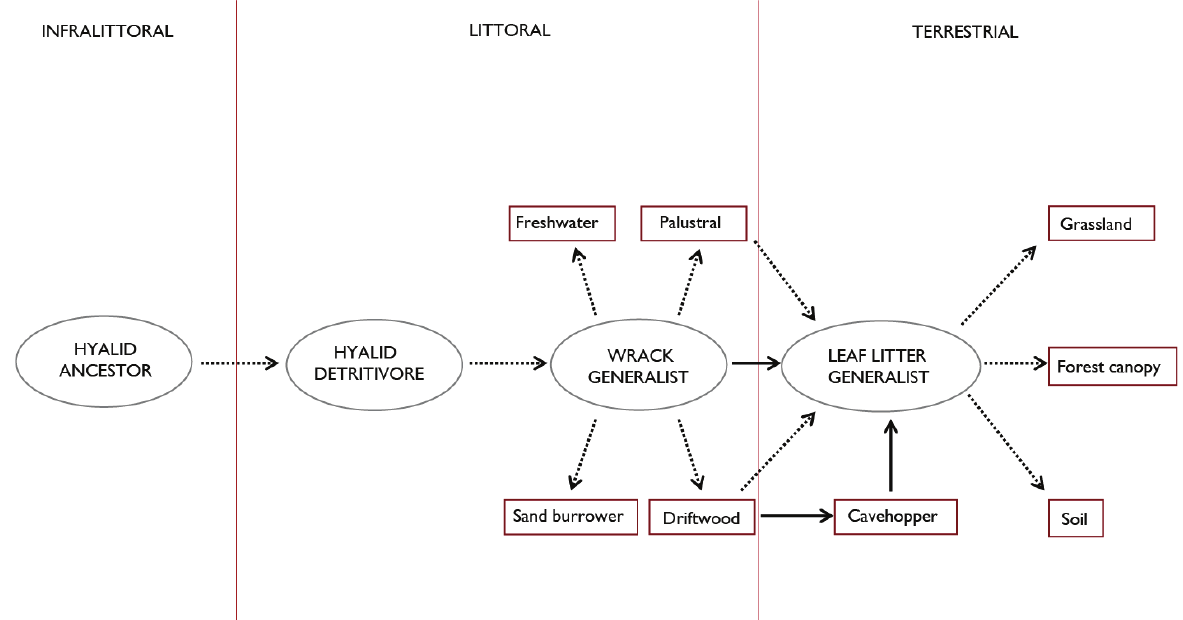
Figure 2. Hypothetical pathway of land colonization by talitrids. Oval boxes are generalists, oblong boxes are specialists. Dashed arrows are hypothetical and those with solid arrows indicate some genetic